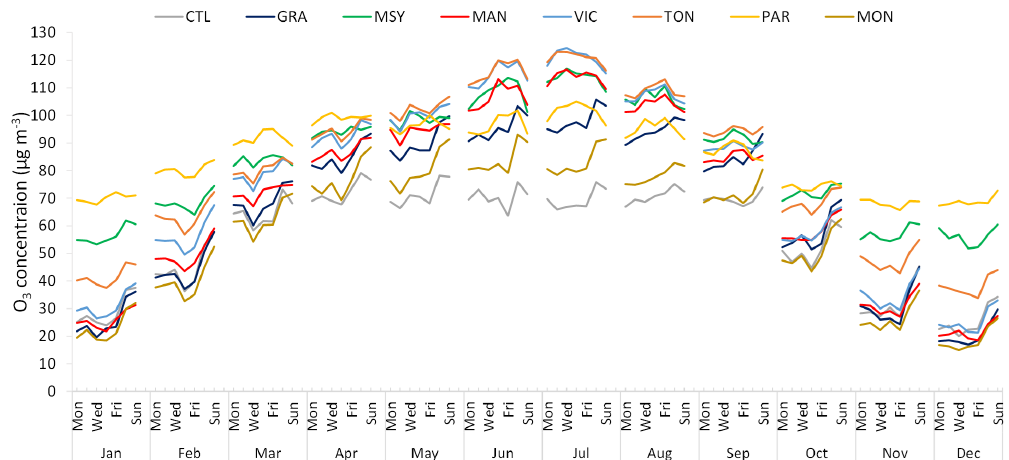
Figure 7. Monthly weekday average concentrations of O 3 concentrations calculated between 12:00 and 19:00LT along the S–N axis during 2005–2017. Data from Ciutadella (CTL), Montcada (MON), Granollers (GRA), Montseny (MSY), Tona (TON), Vic (VIC), Manlleu (MAN) and Pardines (PAR) air quality monitoring